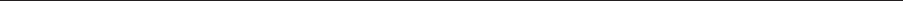
Table 1. Most uncertain ( n ,γ ) reactions (from Ba to Pb) along the i-process path (at a neutron density of ∼ 10 15 cm − 3 ), according to the three di ff erent nuclear models A, B and C. Reactions are included when at least one of the ratios of the Maxwellian-averaged cross sections from di ff erent models (at T = 250 MK, given in the table) is higher than